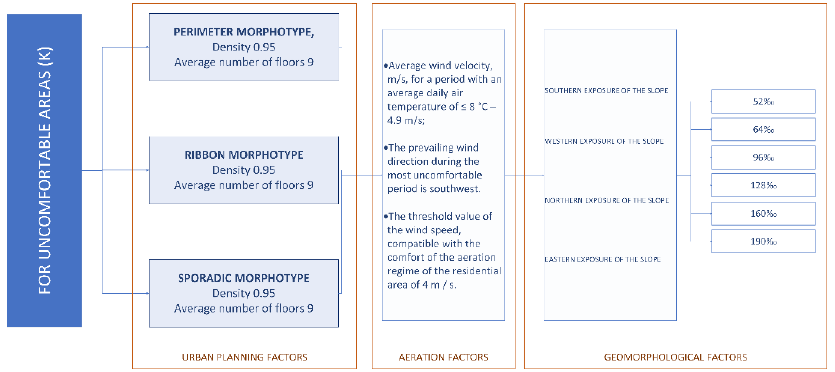
Figure 10. A systematic approach to the study of the aeration regime of residential construction on the sloping lands of the Arctic zone of the Russian Federation.